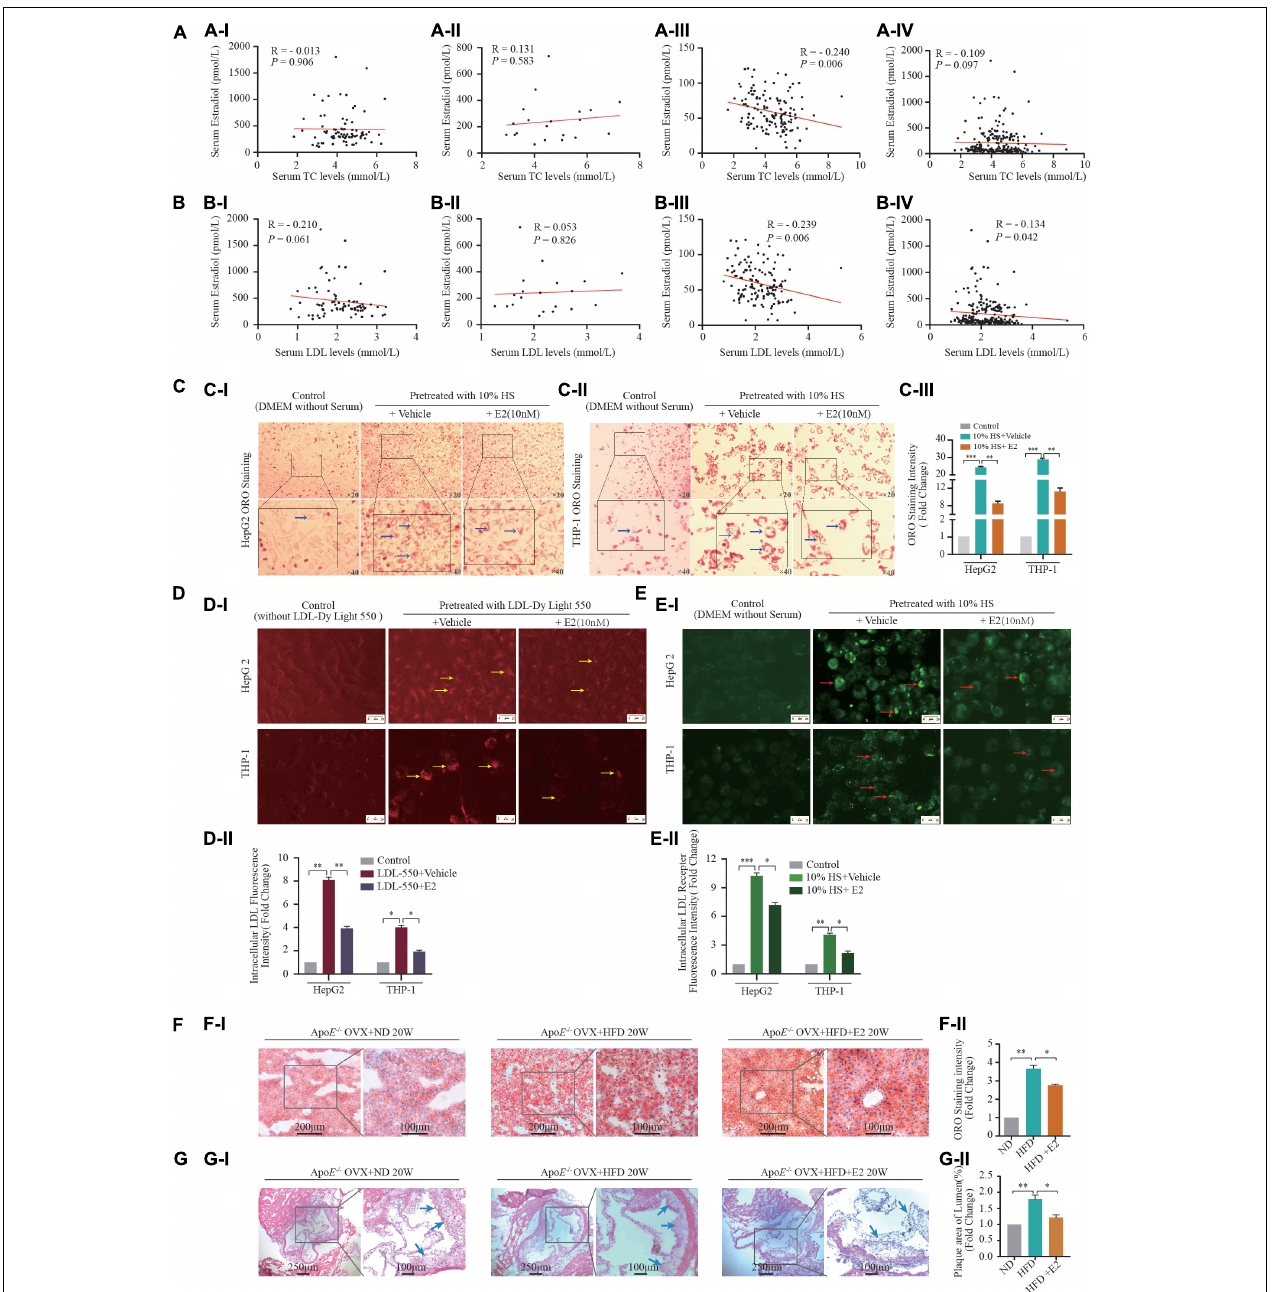
FIGURE 1 | Estrogen affects lipid metabolism in vivo and in vitro . (A,B) A total of 231 healthy women (21–70 years) who experienced natural menstrual states were recruited. Correlation of serum 17- β estradiol [estrogen (E2)] levels and TC in premenopausal (AI) ( n = 80), perimenopausal (AII) ( n = 20), postmenopausal (AIII) women ( n = 131), and all female participants (AIV) ( n = 231); correlation of serum E2 levels and LDL-C in premenopausal (BI) ( n = 80), perimenopausal (BII) ( n = 20), postmenopausal (BIII) ( n = 131) women and all female participants (BIV) ( n = 231); (C) In order to build an in vitro foam-cell environment to mimic the postmenopausal state, mixed hyperlipidemic serum (HS) from post-menopause females ( n = 26) were used to pretreat HepG2 cells and THP-1 macrophages. After stimulated by 5% FBS and 10% HS with or without E2 treatment for 24 h, intracellular lipid accumulation in vitro was measured by the ORO staining assay. Representative images from at least three independent experiments are presented (CI) . Total area of lipid droplets normalized to cell number ( n = 5 ∼ 8 cells/field/slice, n = 3 slices/group) was determined using Image J software and shown in (CII) . (D) HepG2 cells and THP-1 macrophages stimulated by fluorescence labeling LDL (LDL-Dy Light 550) were treated with vehicle or with E2 (10 nM) for 24 h, Representative fluorescence images of intracellular LDL in HepG2 cells and THP-1 macrophages were shown in (DI) . Unstimulated HepG2 cells and THP-1 macrophages were set as controls. Total area of labeling LDL normalized to cell